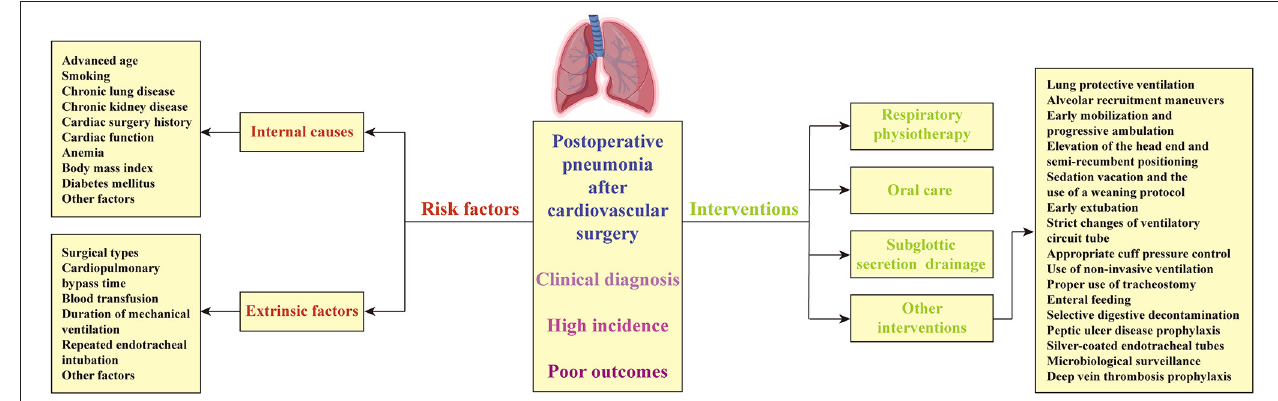
FIGURE 1 | Incidence, risk factors and interventions of pneumonia after cardiovascular